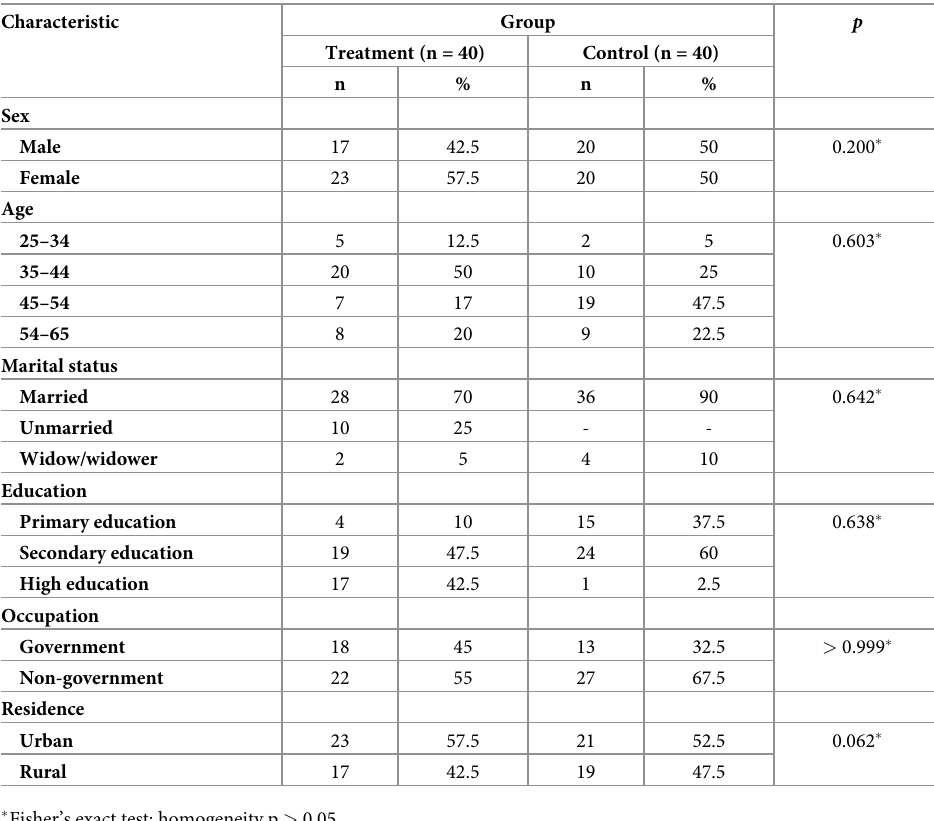
Table 2. Respondent’s characteristic demography. Characteristic